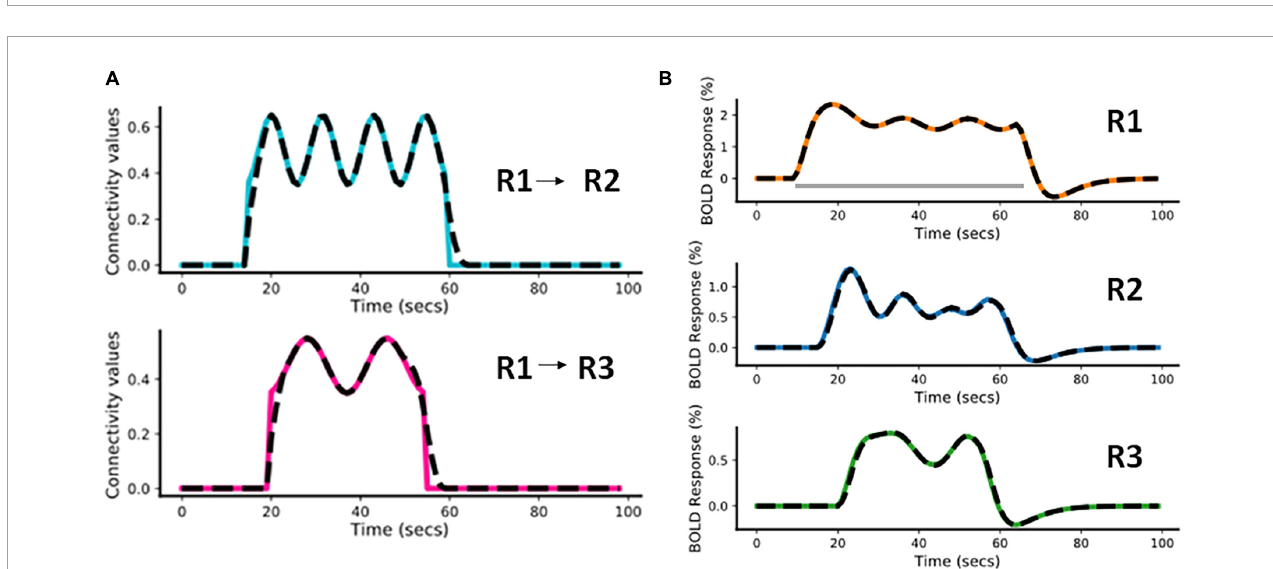
FIGURE4 Predicted estimates along with the ground truth values for Case a. The black dashed lines represent the predicted responses and the colored time courses are the ground truth values. (A) Connectivity time courses, (B) area-specific functional magnetic resonance imaging (fMRI) blood oxygenation level-dependent (BOLD) time courses each expressed as a percentage change in response. The gray horizontal bar represents the stimulus